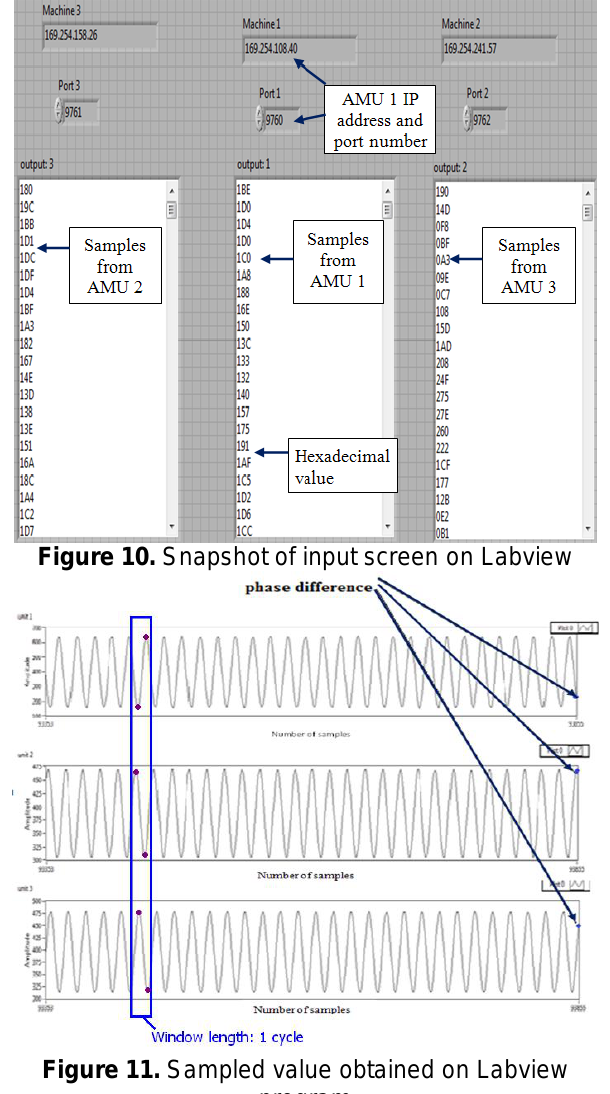
Figure 11. Sampled value obtained on Labview program